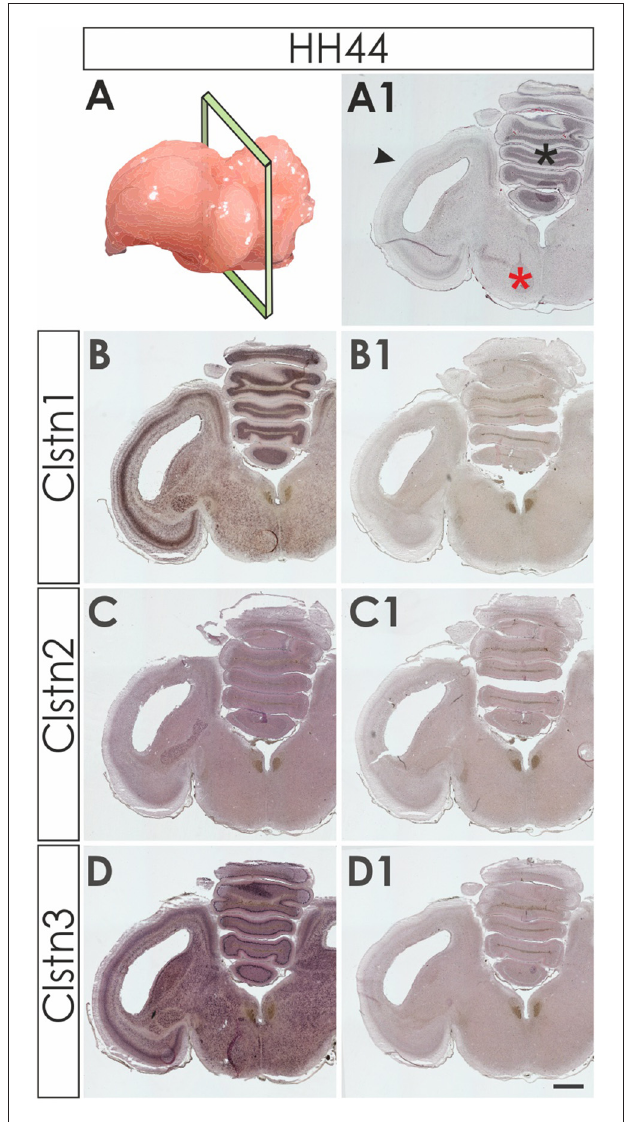
FIGURE 3 | Calsyntenins are widely expressed in the brain shortly before hatching. Coronal sections taken from HH44 brains as indicated in ( A,A1 for H&E stained section) were used to analyze the expression of the calsyntenins. Clstn1 (B) and Clstn3 (D) but not Clstn2 (C) were found in the cerebellum (asterisk in A1 ), the tectum (black arrowhead in A1 ) and in the brain stem (red asterisk in A1 ). Sections (B1,C1,D1) were processed with the respective sense probes. Bar: 1